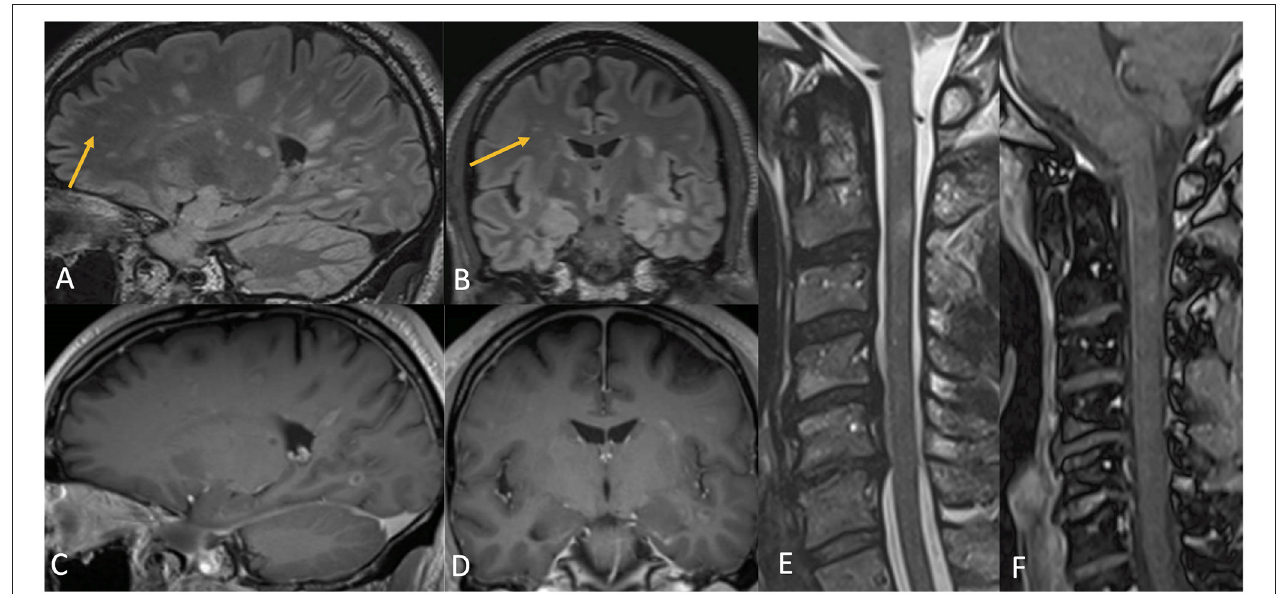
FIGURE 6 | Case 4: Contrast MR brain demonstrating numerous T2 hyperintense lesions involving both the white and gray matter, many of which, but not all, had corresponding complete and incomplete ring enhancement [ (A–D) , arrows pointing to non-enhancing lesions]. Contrast MR cervical spine demonstrates multiple abnormal T2-hyperintense signal lesions (E) with enhancement (F) of the spinal cord, most prominent at the level of the C2 and C3